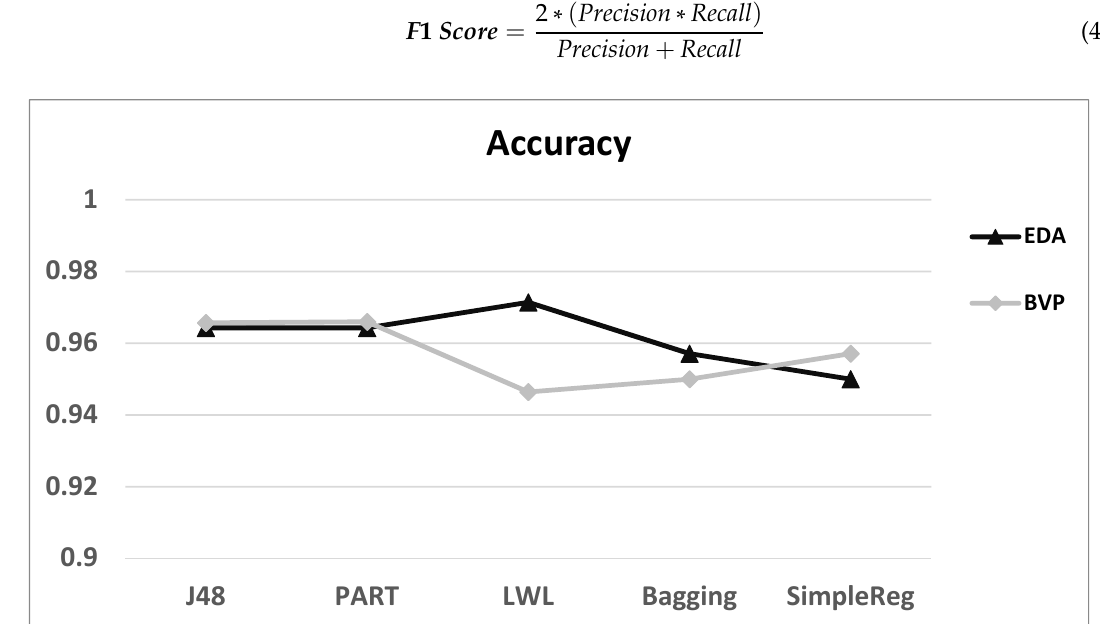
Figure 1. Average accuracy of predictions using the five algorithms: Results using EDA and BVP for correctly predicting ASD vs. Rett participant grouping across the total sample. Abbreviations and